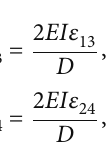
Figure 2: Schematic diagram of the installation of the measuring points: (a) surface strain gauge installation in station hall, (b) surface strain gauge, (c) position and layout of measuring points in whole cross section, (d) layout of the four surfaces strain gauge, and (e) surface strain gauge installation in platform